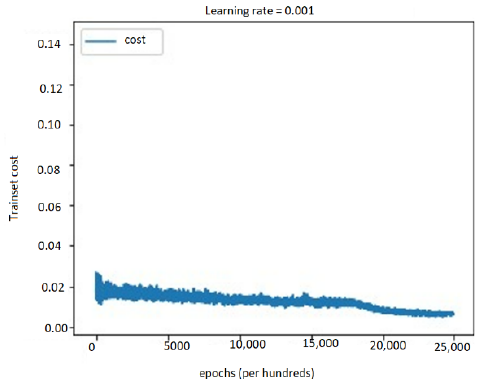
Figure 16. Training cost versus epochs for the multimodal system.